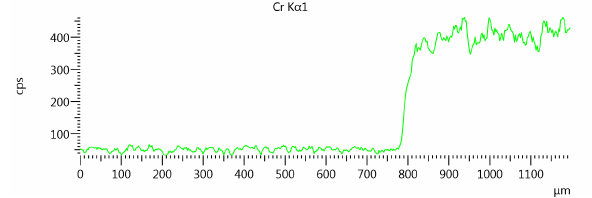
Figure 14: Chromium amount alongside measurement line